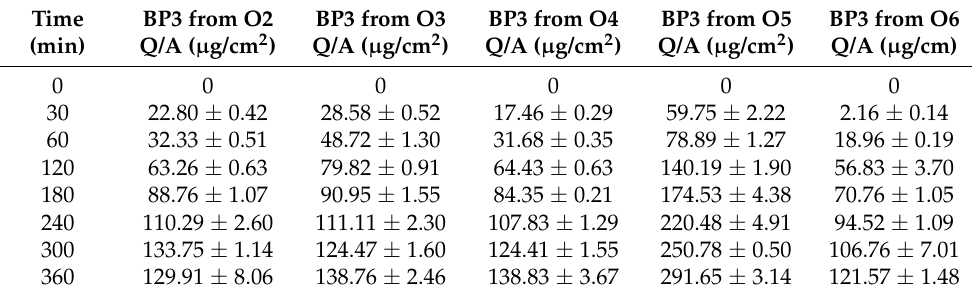
Table 7. Cumulative active release from the different oils: Q is the quantity of compound traversing the membrane in time t, and A is the area of exposed membrane in cm 2 . Each value was obtained from four experiments (mean ±